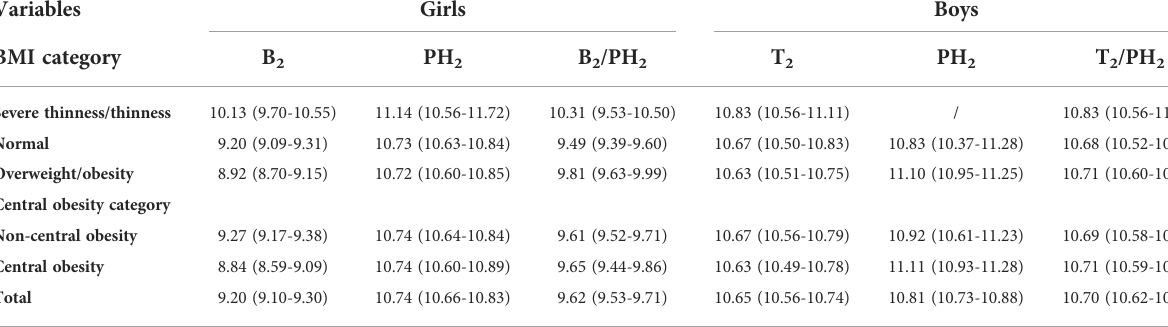
TABLE 2 Median age (95% CI) of attainment of different pubertal stages according to probit analysis. Variables